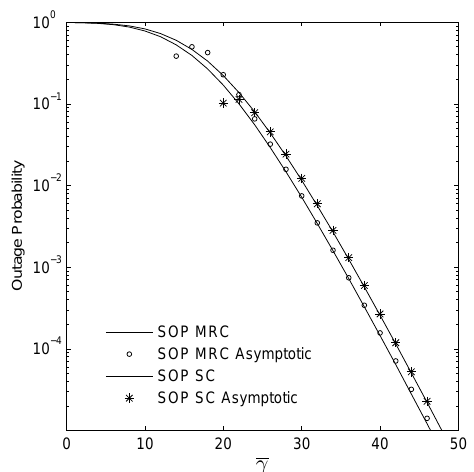
Figure 6. Outage Probability versus the position of primary user with γ = 30, PR = (0.4,0.2), R = 1 dB and η = 3